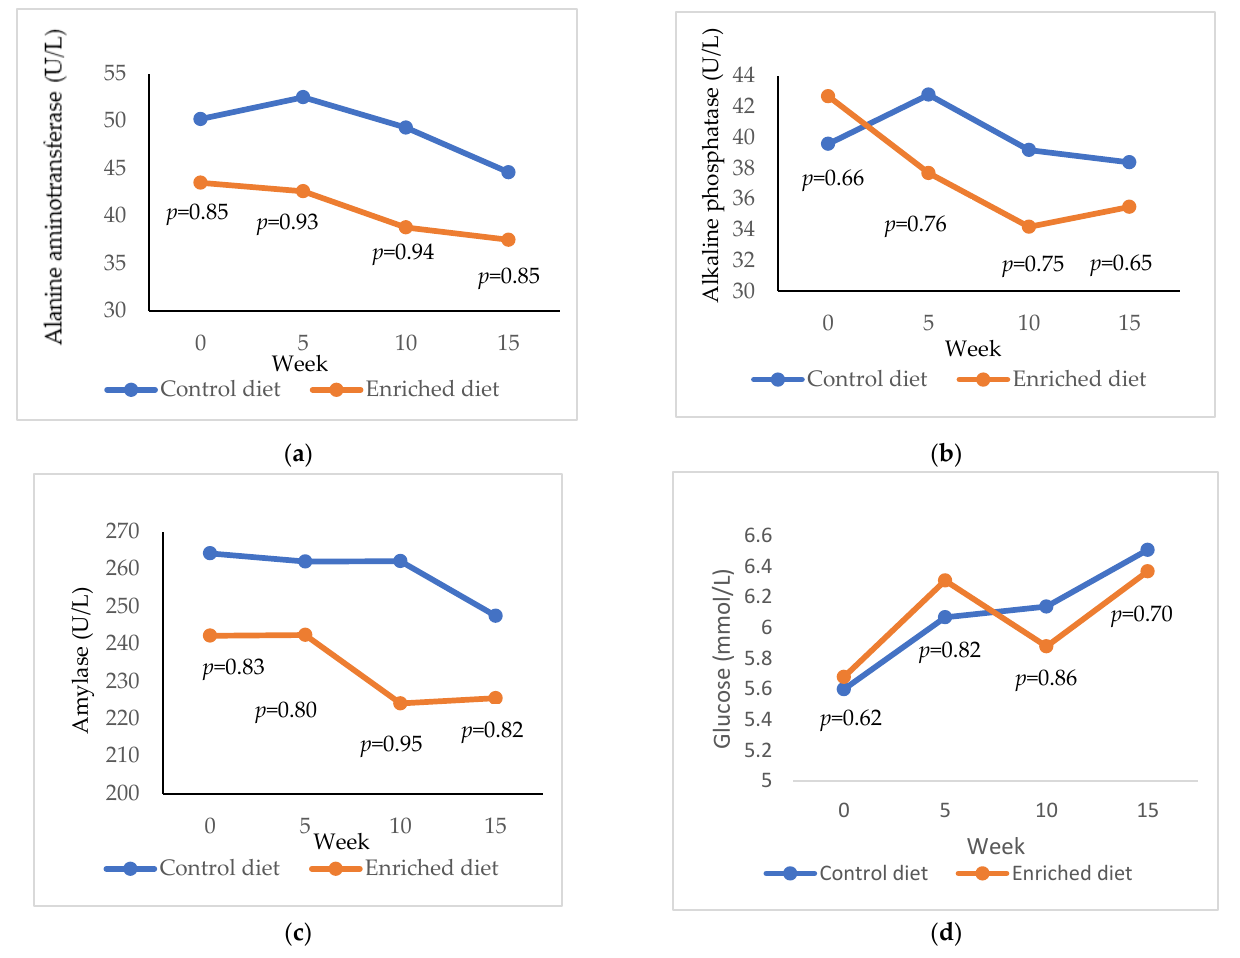
Figure 3. Evolution of ( a ) alanine aminotransferase; ( b ) alkaline phosphatase; ( c ) amylase; ( d ) glucose in males fed with Control and Enriched diet. p is the probability of the difference being >0 when the difference between the diets was >0 or being <0 when this difference was <0.